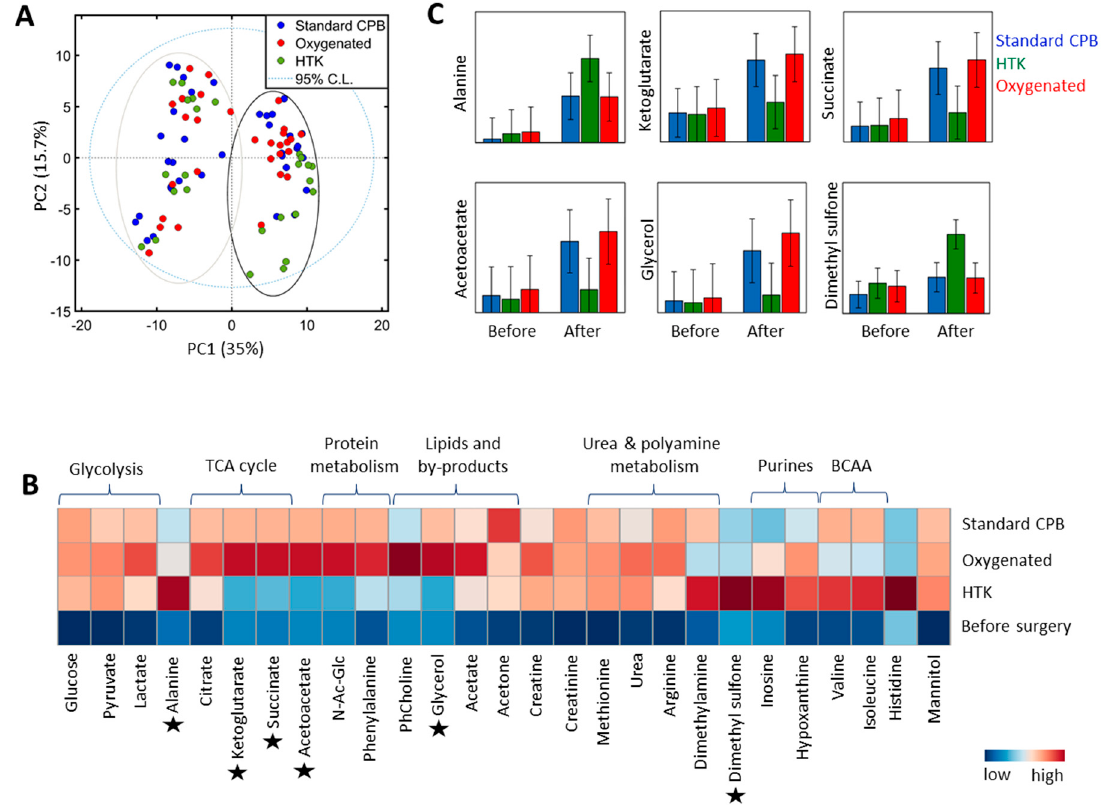
Figure 3. Lung metabolic profiles. ( A ) Principal component analysis (PCA) before ( − PC1 axis) and after CPB (+PC1 axis) colored by the treatment received (standard CPB, blue; oxygenated blood, red; HTK, green). ( B ) Averaged heat-map representation of samples collected before (bottom raw) and after CPB (second to forth raw). Data are normalized to total intensity and auto-scaled, colored coded according to the levels of metabolites identified at a particularly time point and group; e.g., blue represent lower concentrations of metabolites, while red represents metabolites in which concentration increased post-CPB. Six metabolites presenting different trends across the groups are marked (*) and further displayed in ( C ) with mean and 95% confidence intervals. TCA: tricarboxylic cycle acid; BCCA: branch chain amino acid.